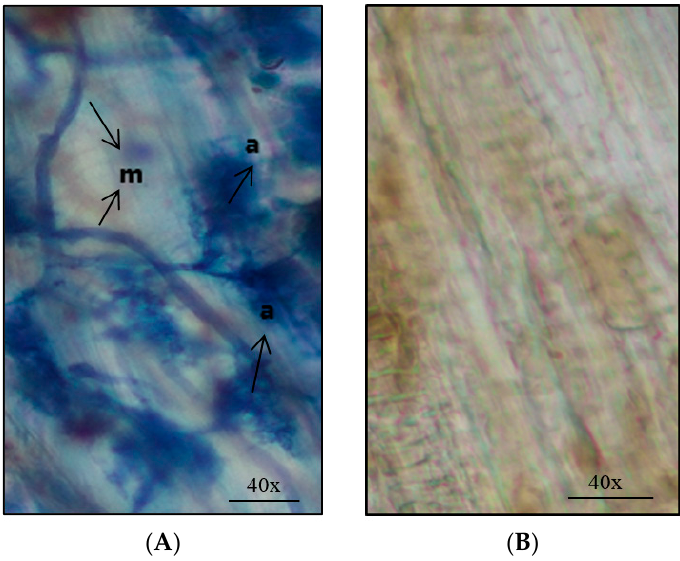
Figure 4. Microscopic image of ( A ) the presence of mycelium (m) and arbuscule (a) of AM fungi in the tomato root and ( B ) its absence in control samples.